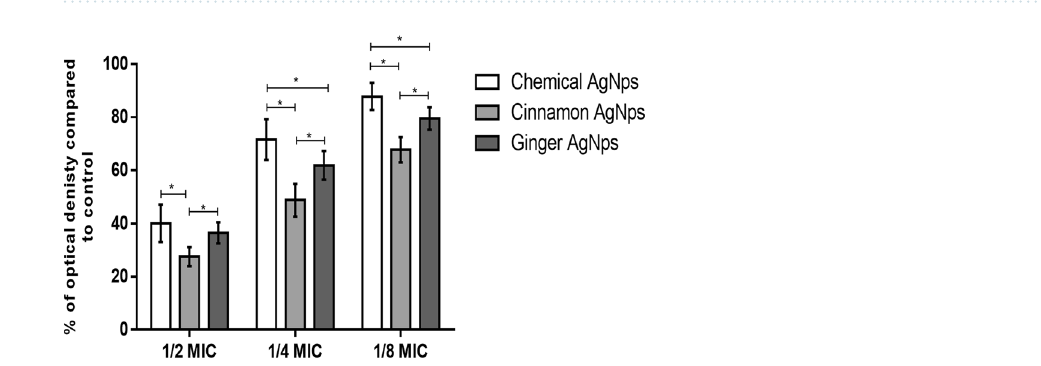
solution from light yellow to dark reddish-brown for cinnamon AgNPs and from colorless to deep yellow for ginger AgNPs. These findings were compatible with previous studies that synthesized cinnamon and ginger AgNPs 24,25 . UV–visible spectroscopy was used as an effective way to confirm the synthesis of AgNPs 16 . Cinna- mon and ginger AgNPs showed SPR peaks around 402.7 and 424 nm, respectively. The obtained results agreed with previous studies done by Sathishkuma et al . and Yang et al . that reported that cinnamon and ginger AgNPs showed bands with peaks at 426 nm and 423 nm, respectively 24,26 . Comparing our findings with the previous results, it was revealed that both cinnamon and ginger AgNPs were synthesized.